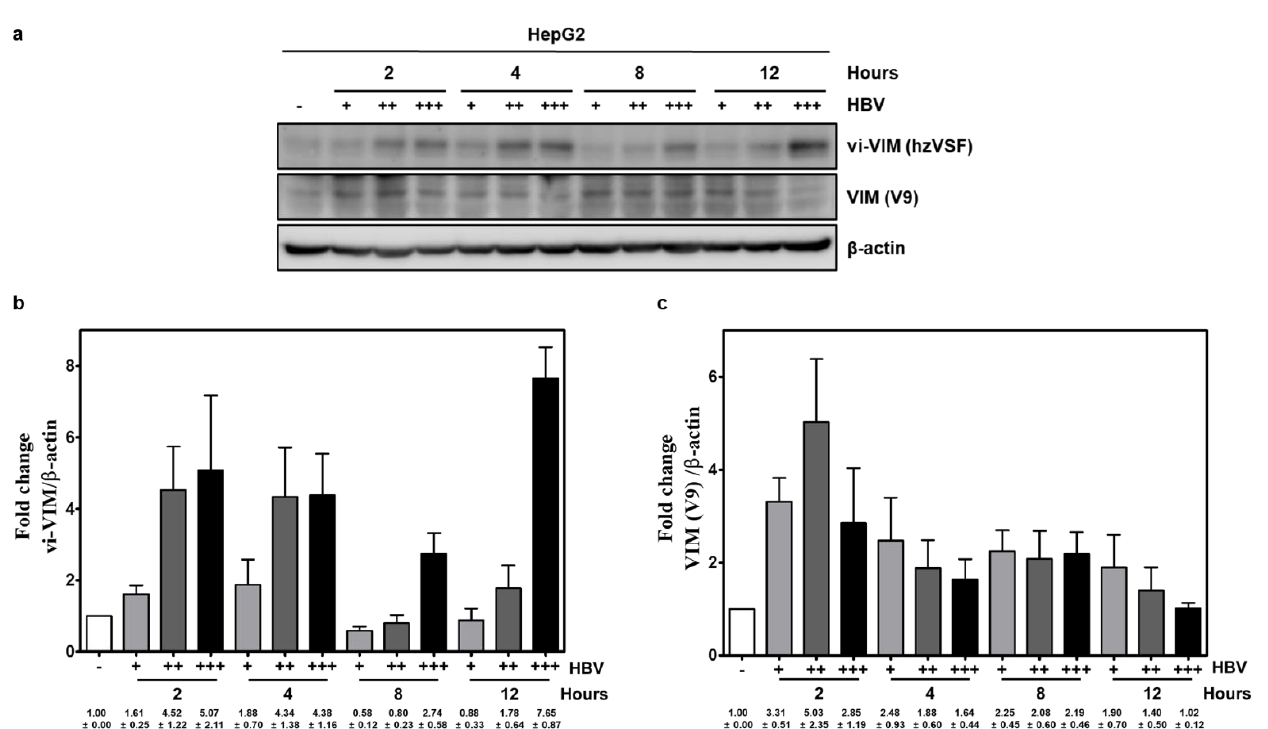
Figure 2. vi-VIM is induced by HBV in human hepatoma cells. ( a ) HepG2 cells were infected with increasing doses of precipitated HBV derived from the supernatant of HepG2.2.15 cells (i.e., + = 50 μL, ++ = 150 μL, and +++ = 300 μL of the HBV precipitate). Changes in vi-VIM level were detected with the humanized hzVSF antibody at 2, 4, 8, and 12 h pi. Parallel changes in intracellular VIM levels were assayed with the V9 antibody. Changes in protein signal were normalized to β -actin and averaged for three replicates, and are presented ( b ) for vi-VIM and ( c ) intracellular VIM as a mean ± standard error of the mean.